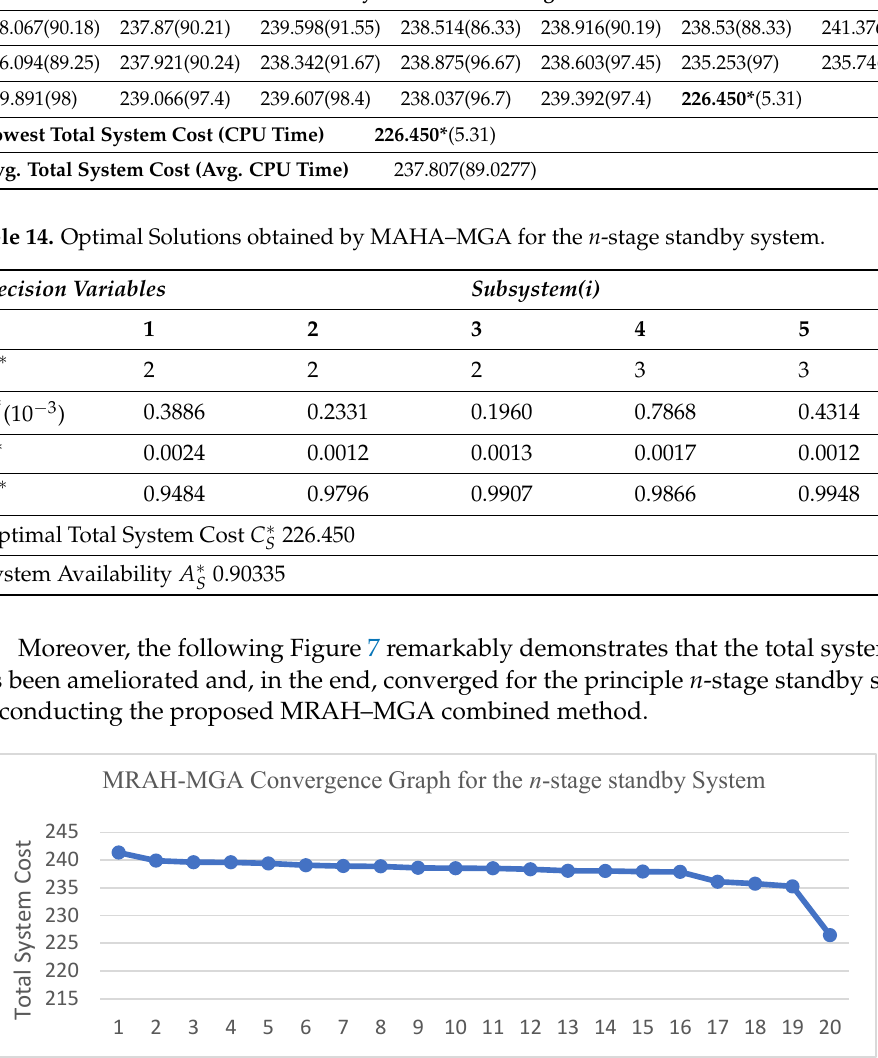
Figure 7. The convergence graph of the n -stage standby system by conducting the MRAH-MGA combined method.